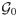
Cell networks.(A) The graph G0 with n = 4 and m = 6. (B) A random version of it. Each link from G0 was removed with a given probability p(v). Holes are allowed by choosing some threshold for removing nodes. (C) Each cell contains two components: the cytoplasmic compartment (Cyt) and the endoplasmic reticulum (ER). Neighboring cells exchange Ca2+ ions through their cytoplasmic compartments defined by the gap junctional coupling parameter d. (D-E) Graphical representation of JINF(v, t) (D) and InsP3(v, t) (E) in a simple inhomogeneous 2 × 2 grid with cells label by v11, v12, v21, v22. See Eqs (20) and (21). The parameter values of iJINF,max(v), iIP3,max(v) and t1(v) are represented graphically in order to illustrate our correlations assumptions.